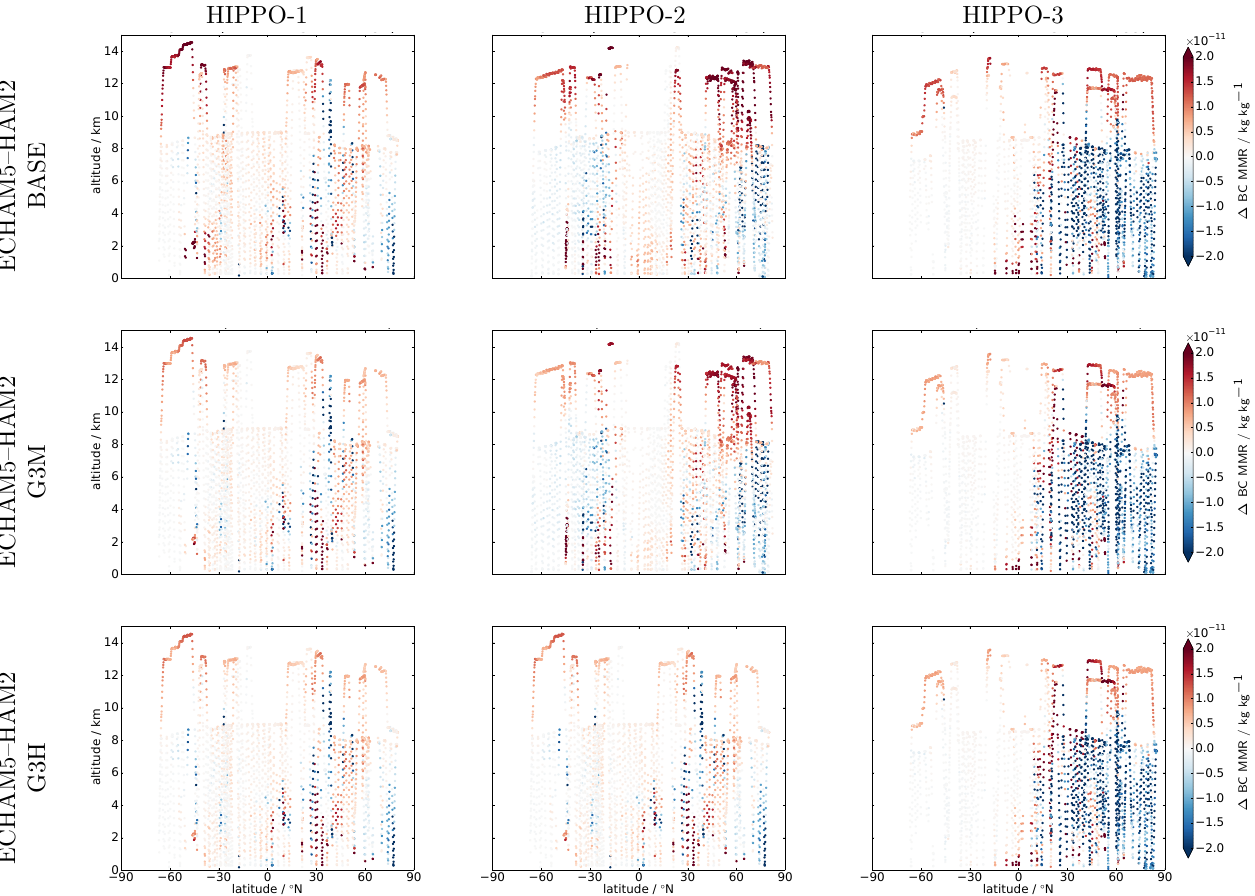
Fig. 4. Difference of BC mass mixing ratio (kgkg − 1 ) simulated by ECHAM5–HAM2 in each configuration (rows) from that observed during each phase of the HIPPO campaign (columns). The model is nudged and sampled along the HIPPO flight track at 1-min intervals; observed mixing ratio is calculated from HIPPO SP2 data aggregated over 1-min